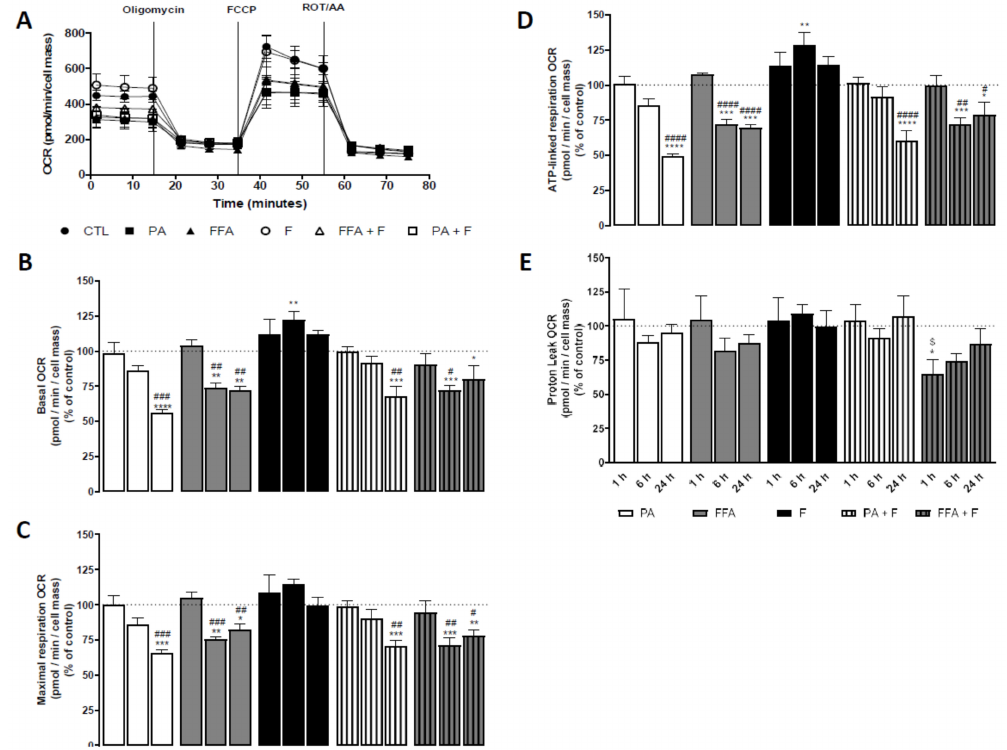
Figure 5. Time-dependent effect of supra-physiological concentration of FA on mitochondrial oxygen consumption. ( A ) Typical representation of oxygen consumption rate (OCR) measurement in HepG2 cells treated with palmitic acid (PA, 0.5 mM) or a mix of free fatty acids (FFA, 0.25 mM) in the presence or absence of fructose (F, 10 mM) for 1, 6 and 24 h. Several respiratory parameters were evaluated: ( B ) cellular basal respiration; ( C ) maximal respiration; ( D ) ATP production-linked respiration; and ( E ) proton leak. Data are mean ± SEM (expressed as pmol O 2 /min/cell mass) of four independent experiments, and the results normalized on the control condition (CT = 100%, marked by a dotted line. The data obtained for the different treatments was compared with the control group. Significance was accepted with * p < 0.05, ** p < 0.01, *** p < 0.0005, **** p < 0.0001 for comparisons between treatment vs. CTL (BSA 0.01 g/mL) and # p < 0.05, ## p < 0.01, ### p < 0.0005, #### p < 0.0001 for comparisons during time in the same group (24 and 6 h vs. 1 h). Significance for additional fructose effect as accepted with $ p < 0.05. Legend: FCCP—carbonyl cyanide